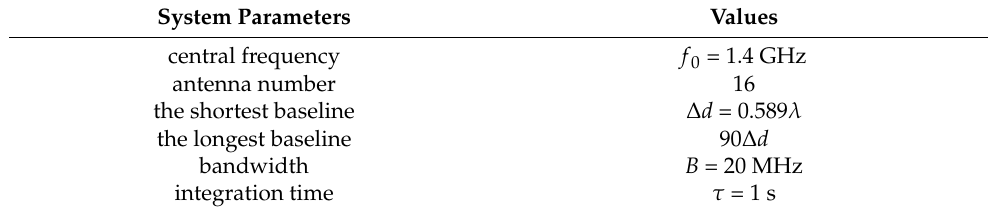
Figure 1. Antenna array. Table 1. The system parameters.